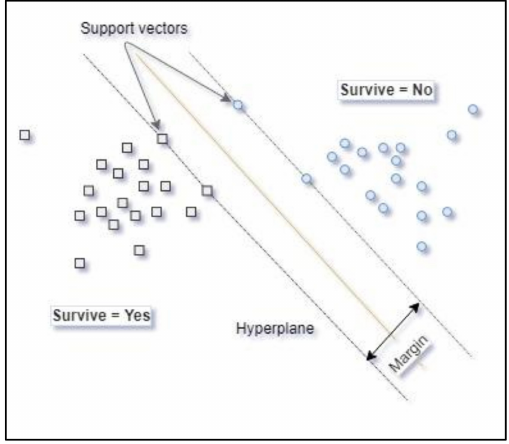
Figure 3. Graphic representation of the SVM